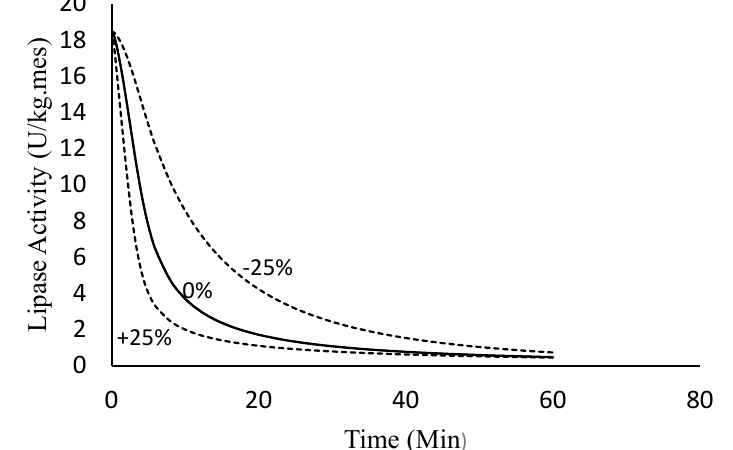
Figure 12. Sensitivity analysis of the model to changes in n d with respect to predicted in vivo lipase activity inside OPF after immersion in hot water at 70 °C for 60 min.